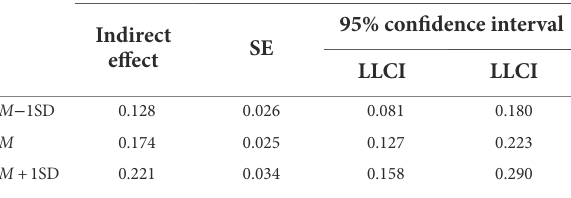
TABLE 11 Results of moderated mediating effect